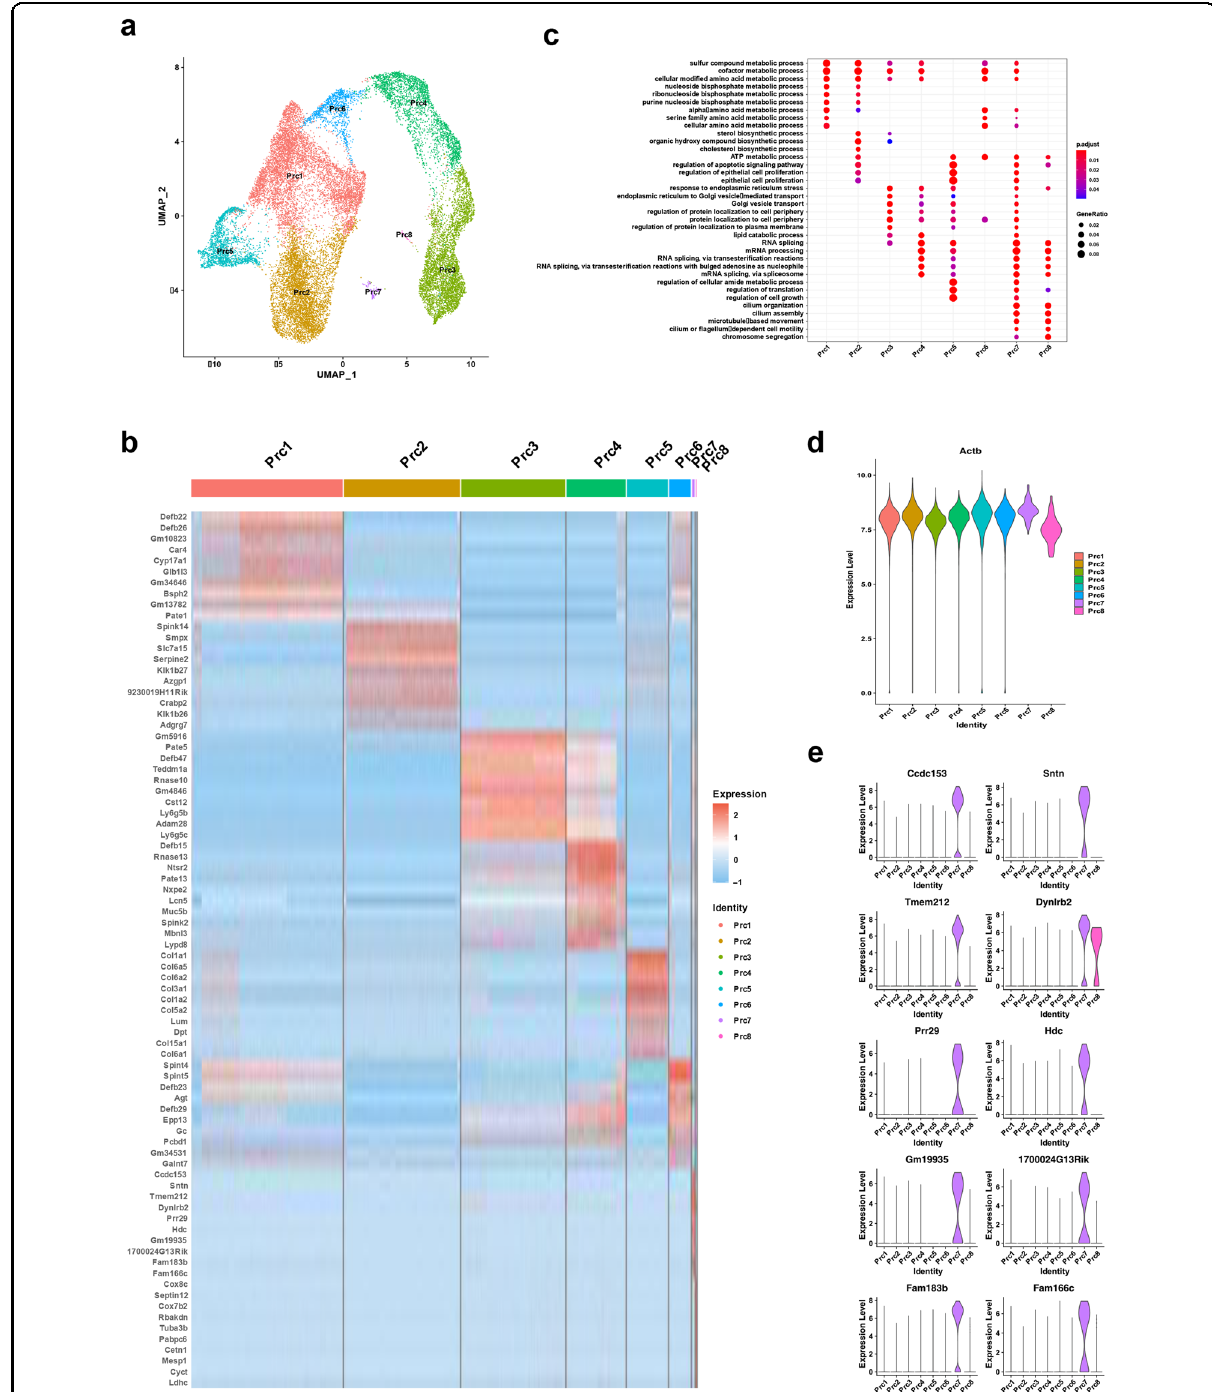
Fig. 2 Features of principal cell subpopulations. a UMAP representation of the subpopulations of principal cells aligned in the caput, corpus, and cauda. Eight subclusters of principal cells were identi fi ed. b Heatmap showing the top 10 marker genes for each subpopulation (log1pRPM scaled by row). c GO enrichment analysis for the principal subpopulation. d Violin plot of actin (Actb) in the principal subpopulation ( y -axis log1pRPM). The expression level of Actb was the highest in the Prc7 subcluster. e Violin plot showing representative marker genes for the principal subpopulation Prc7 ( y -axis